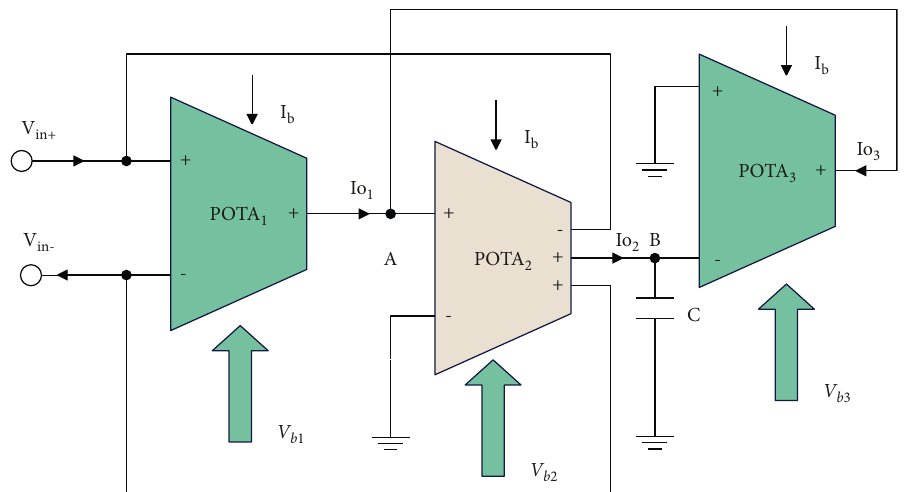
Figure 4: Schematic diagram of the capacitance multiplier circuit based on POTA.